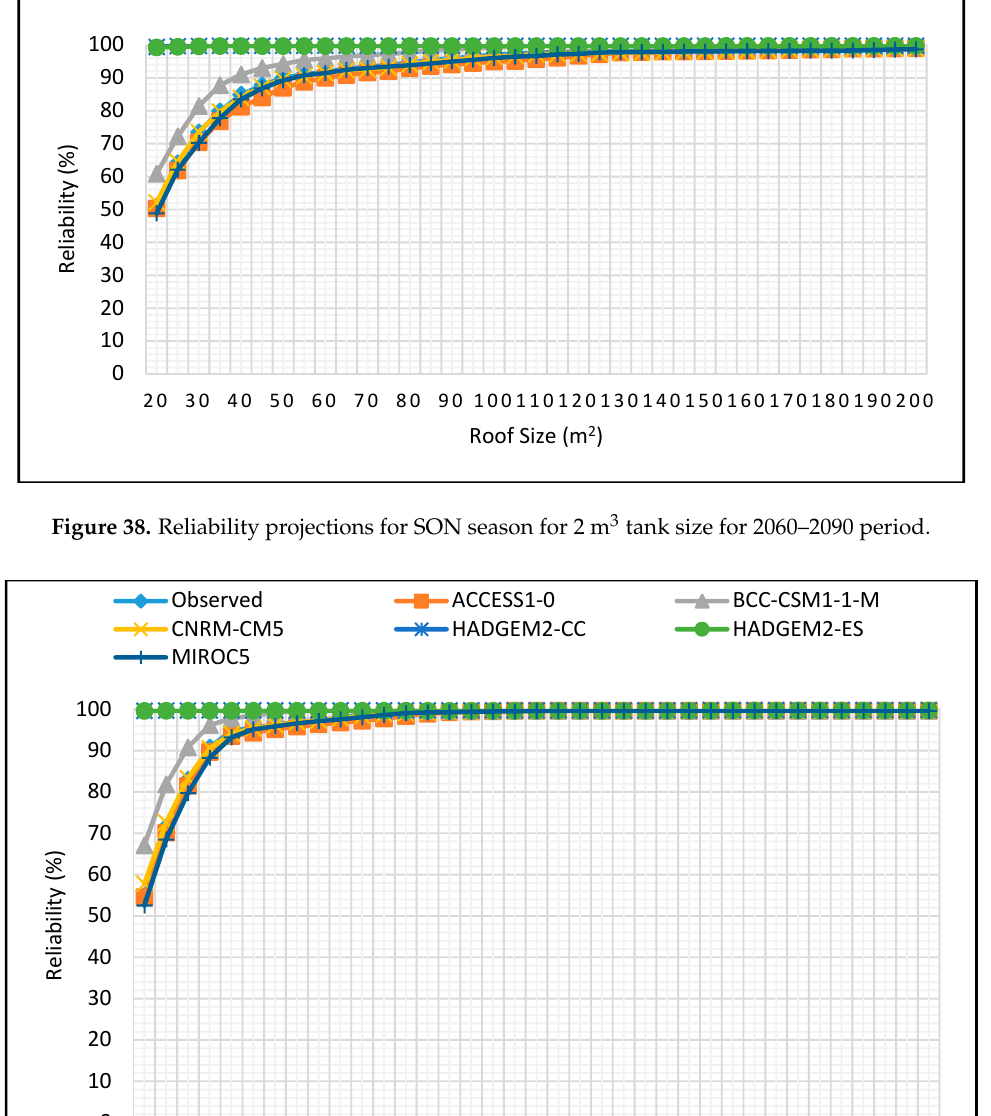
Table 6. Observed and projected water security (%) for MAM rain season.